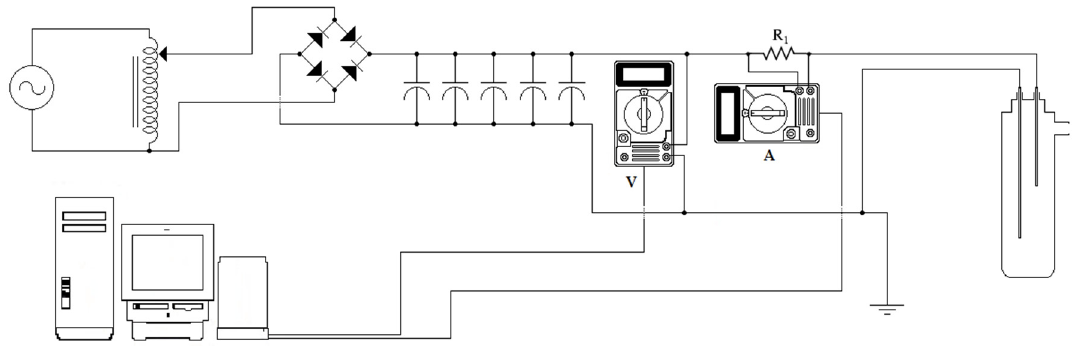
Figure 8. Diagram of the electrical circuit and the elements constituting the experimental apparatus.